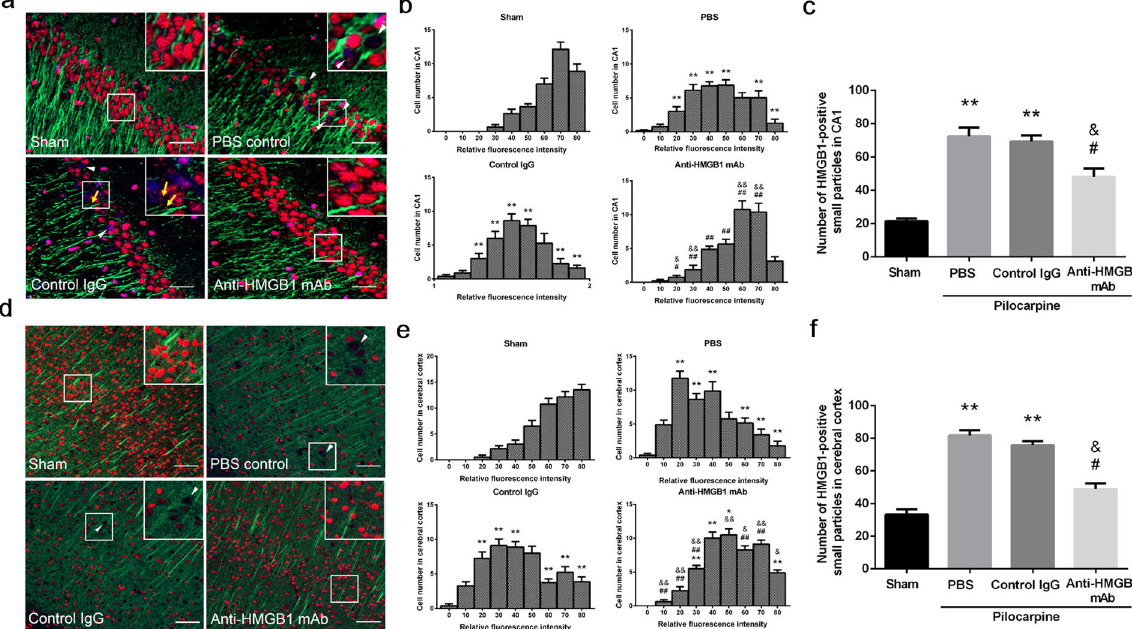
Figure 3. The translocation and release of HMGB1 in neurons in pilocarpine-induced acute status epilepticus. Anti-HMGB1 mAb, control IgG or PBS was administered to stage 5 epileptic mice, and the brains were fixed 4 h later. The CA1 hippocampal region ( a ) and cerebral cortex ( b ) were double-stained with anti-HMGB1 and anti-MAP2 antibodies, followed by Alexa Fluor 555-labeled and Alexa Fluor 488-labeled secondary antibodies, respectively. Scale bars equal 30 μ m ( a ) and 50 μ m ( d ), respectively. Arrowheads (white) indicate the neurons with marked decrease in HMGB1 fluorescence intensity in nuclei. Arrows (yellow) indicate the HMGB1-positive small particles released from nuclei ( a ). The fluorescent intensity of HMGB1 in nuclei was graded into 9 levels and the cell numbers with the indicated fluorescent levels were counted ( b , e ). The total number of HMGB1-positive small particles were also counted in each group ( c , f ). The results are shown as the means ± SEM of 8 mice. ** p < 0.01 compared with the corresponding sham control. & p < 0.05, && p < 0.01 compared with PBS control. # p < 0.05, ## p < 0.01 compared with the control IgG group ( b , c , e , f